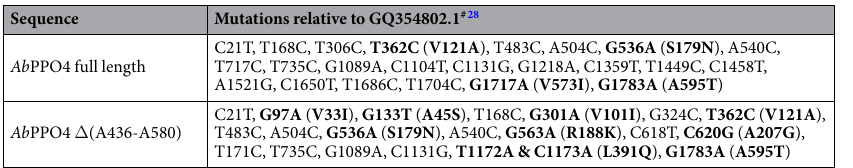
Sequence Mutations relative to GQ354802.1 # 28 Ab PPO4 full length